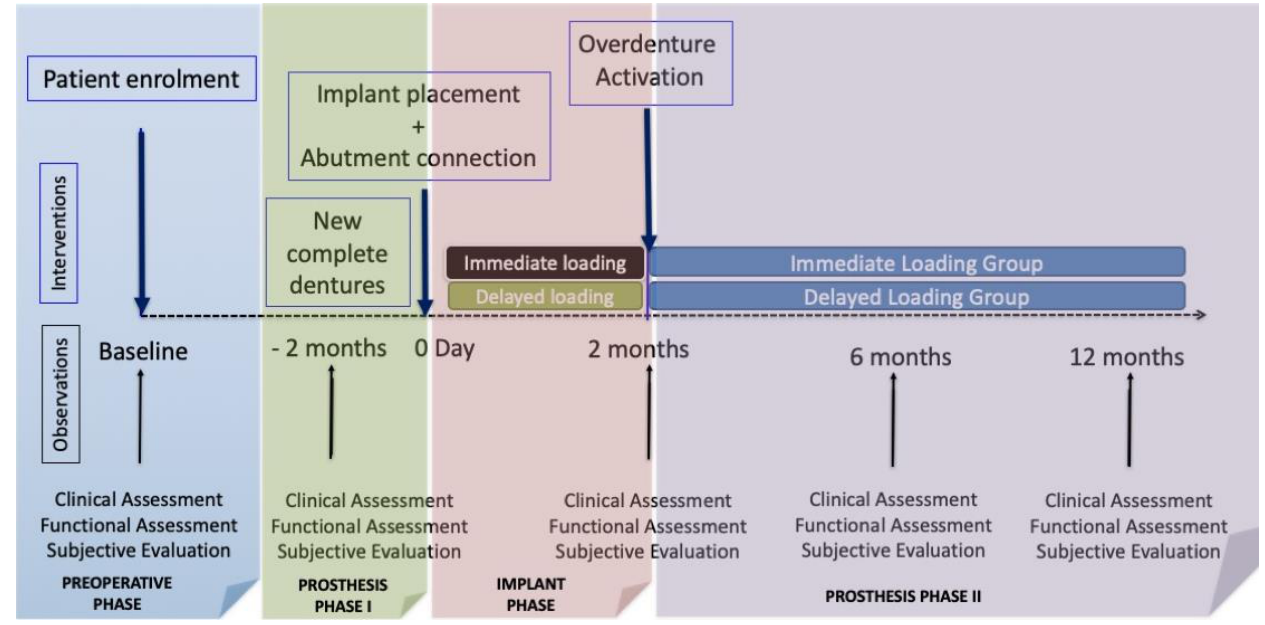
Figure 2. Diagram of the observations and interventions scheduled in the